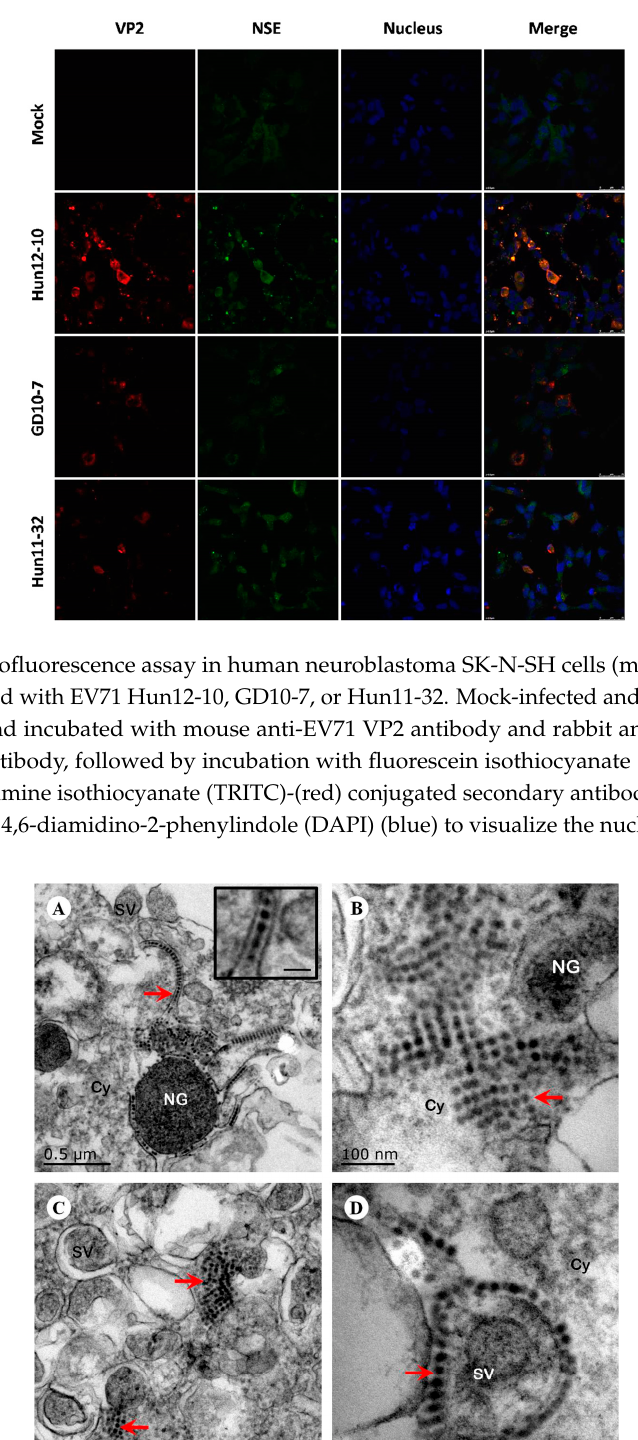
Figure 3. Ultrastructural observation of human neuroblastoma SK-N-SH cells infected with EV71 Hun11-32. ( A ) The viral particles (red arrow) are located in a line between the membranes (scale bar, inset, 50 nm). ( B ) The viral particles (arrow) clustered as crystals in the cytoplasm. ( C ) The viral particles (arrow) clustered as crystals next to the secretory vesicles in the cytoplasm. ( D ) The viral particles (arrow) surrounded the membrane of the secretory vesicles. NG, neurosecretory granules; SV, secretory vesicles; Cy, cytoplasm.